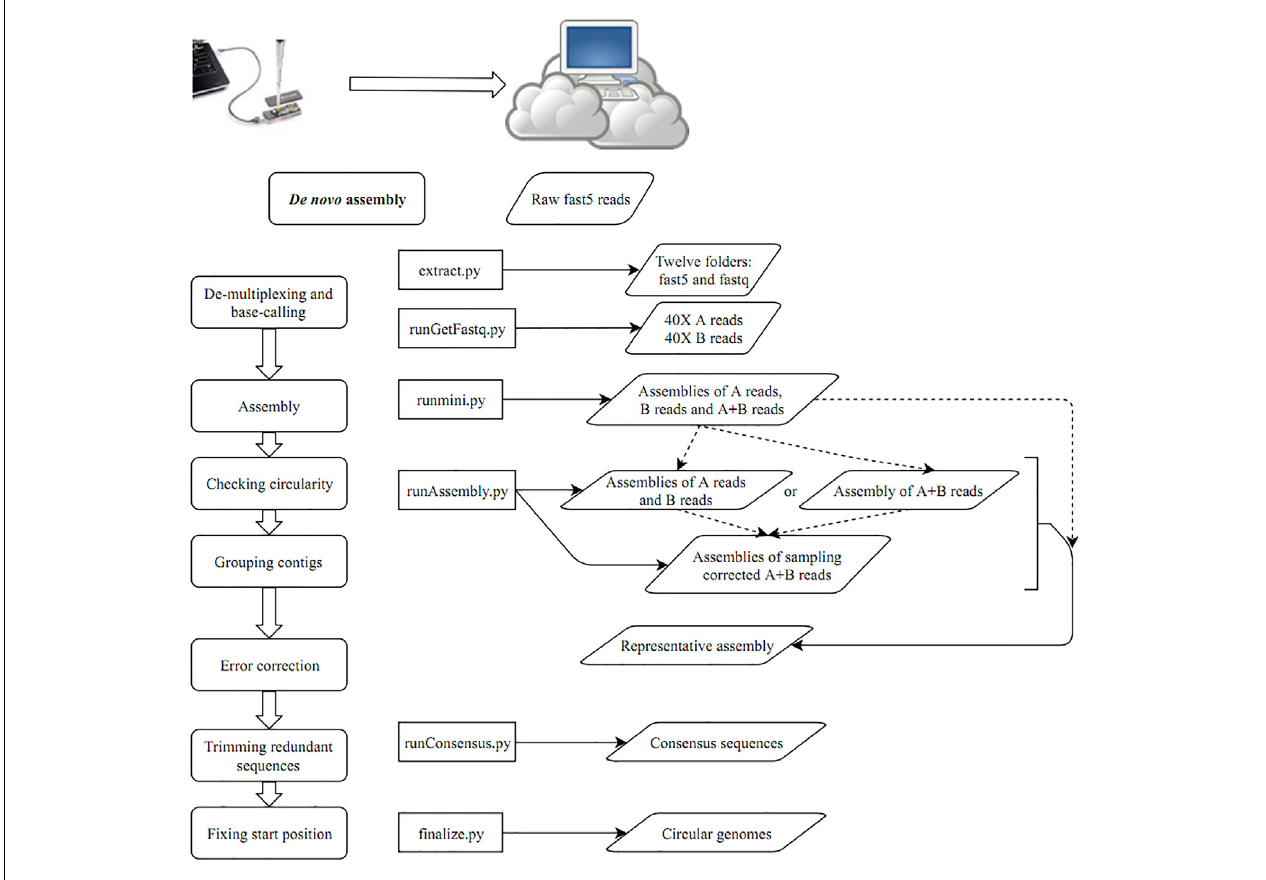
FIGURE 1 | A schematic workflow of